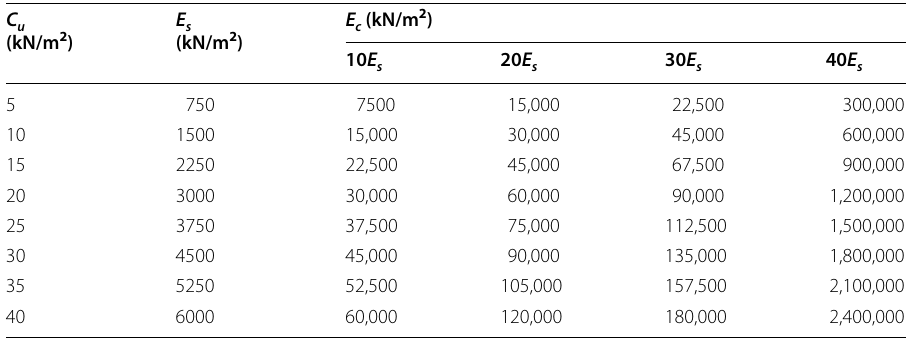
Table 2 Stiffness of surrounding soil and stone